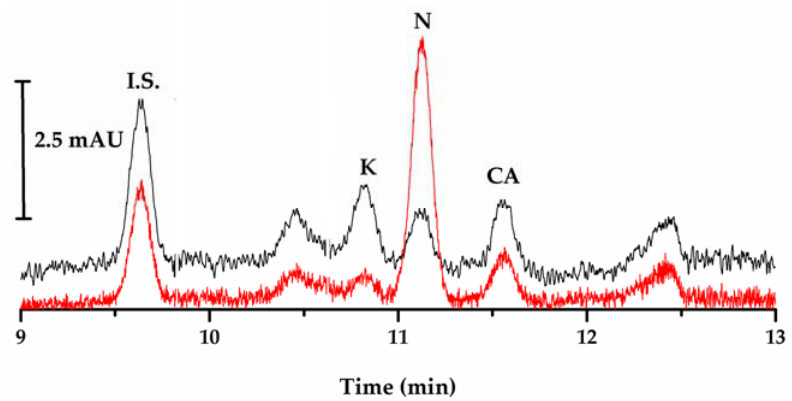
Figure 7. Typical electropherogram obtained under optimum conditions and after off-line SPME with the laboratory-made fiber of a spiked Genil River water sample at 10 µ g · L − 1 of ketoprofen (K), naproxen (N), clofibric acid (CA), and internal standard (I.S.), at 203 nm (black) and 228 nm (red). Table 6. Recovery study results in Genil River water sample.